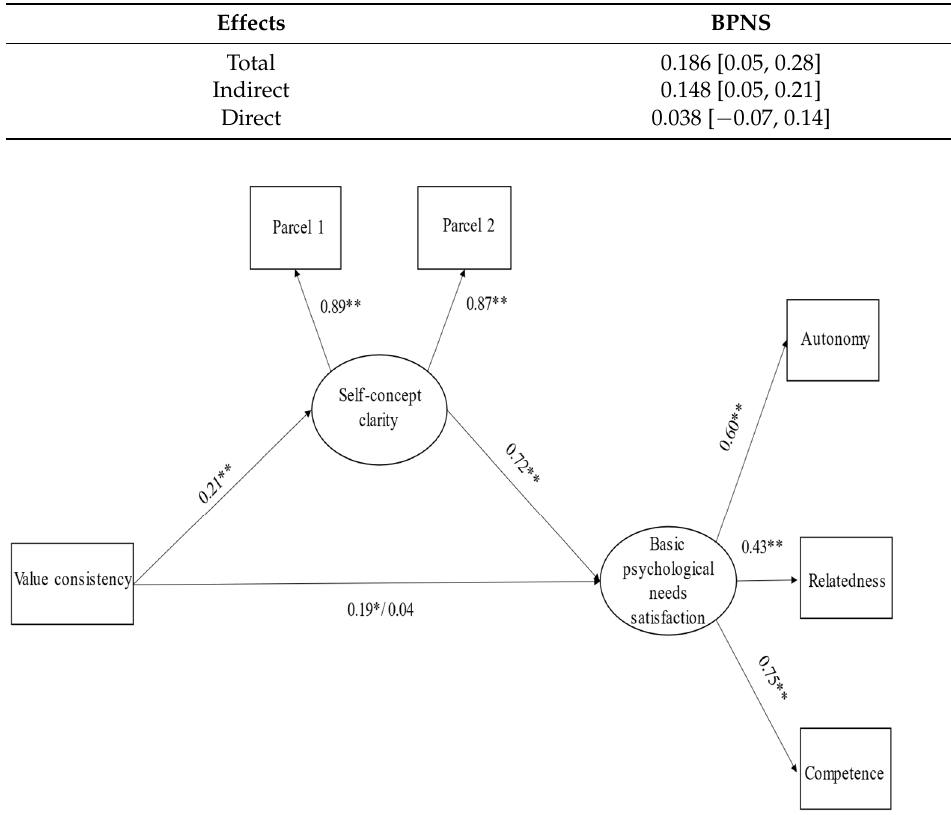
Table 3. Results of the mediation with standardised effects and 95% CI.